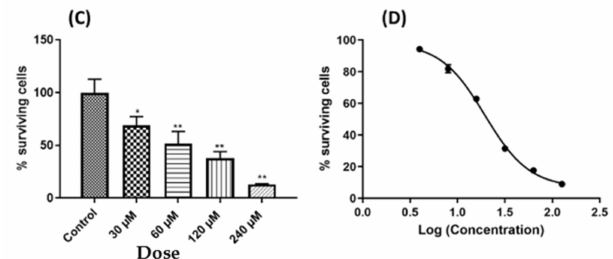
Figure 3. Purification of the bioactive compound using HPLC. The leaf extract was subjected to silica gel chromatographic fractionation, and then each fraction was subjected to a bioassay, as described in Section 4. ( A ) Fraction 3 of the silica gel chromatography was further subjected to preparative HPLC fractionation, and single peaks were further subjected to a bioassay. ( B ) A single peak of a 9.052 min retention time showed anticancer activity, and it was further analyzed on HPLC for purity. ( C ) The purified phytocompound collected as a single peak on HPLC was subjected to an MTT assay after treating the PC3 cells with 30, 60, 120 and 240 µ M for 24 h. The percentage of viable cells of each treated group was calculated after taking the viable numbers of the control cells as 100%. The p -values were calculated using Student’s “ t ” test. The bars indicate SD, * indicates a p -value > 0.05, ** indicates p -value > 0.01. ( D ) The IC50 for the purified phytocompound was measured using GraphPad Prism 8